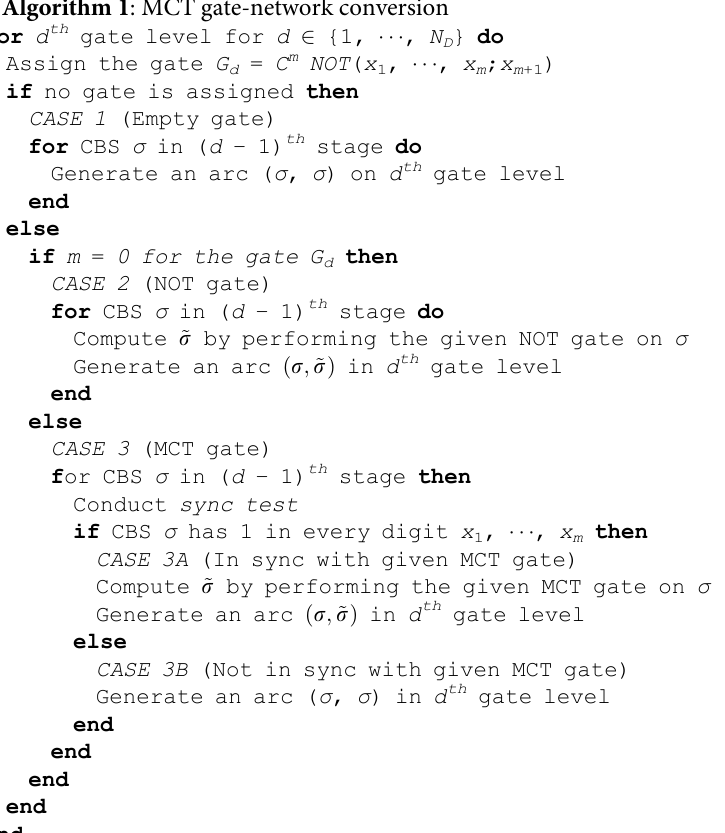
Algorithm 1 : MCT gate-network